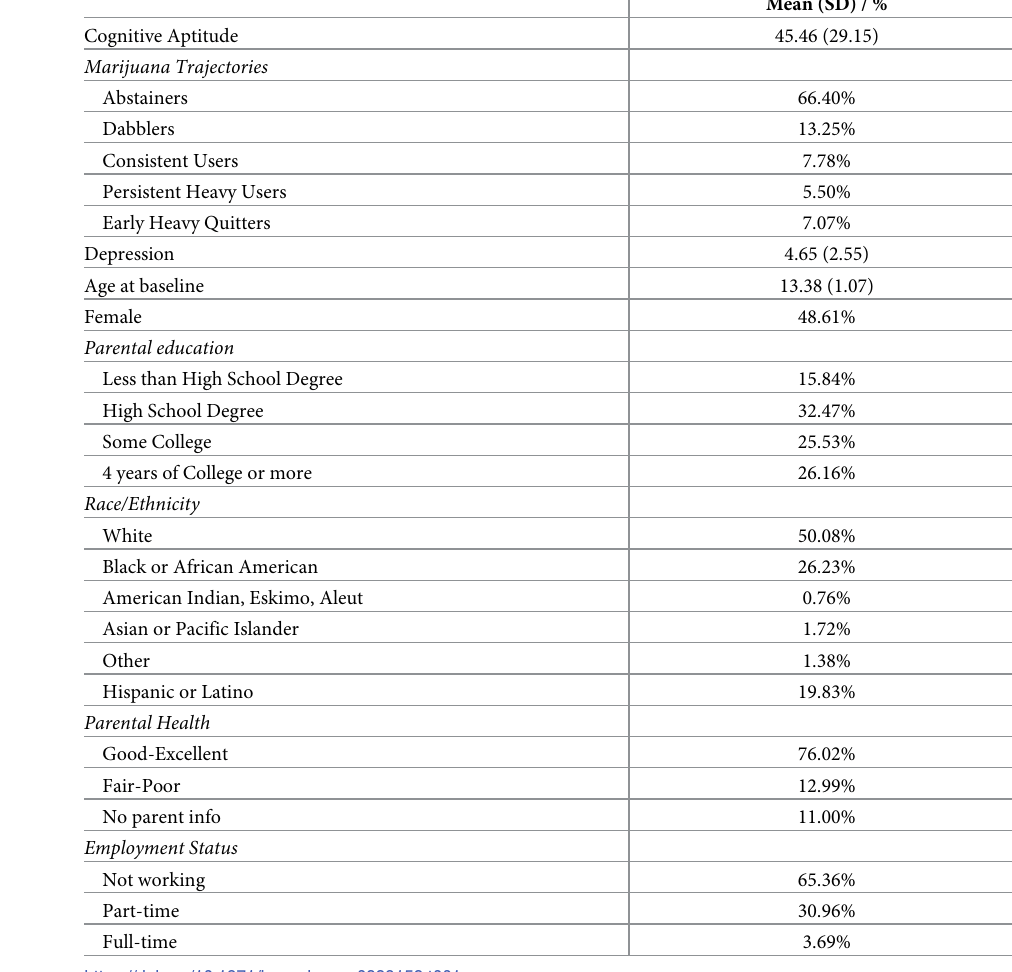
Table 1. Demographic characteristics of NLSY subjects under age